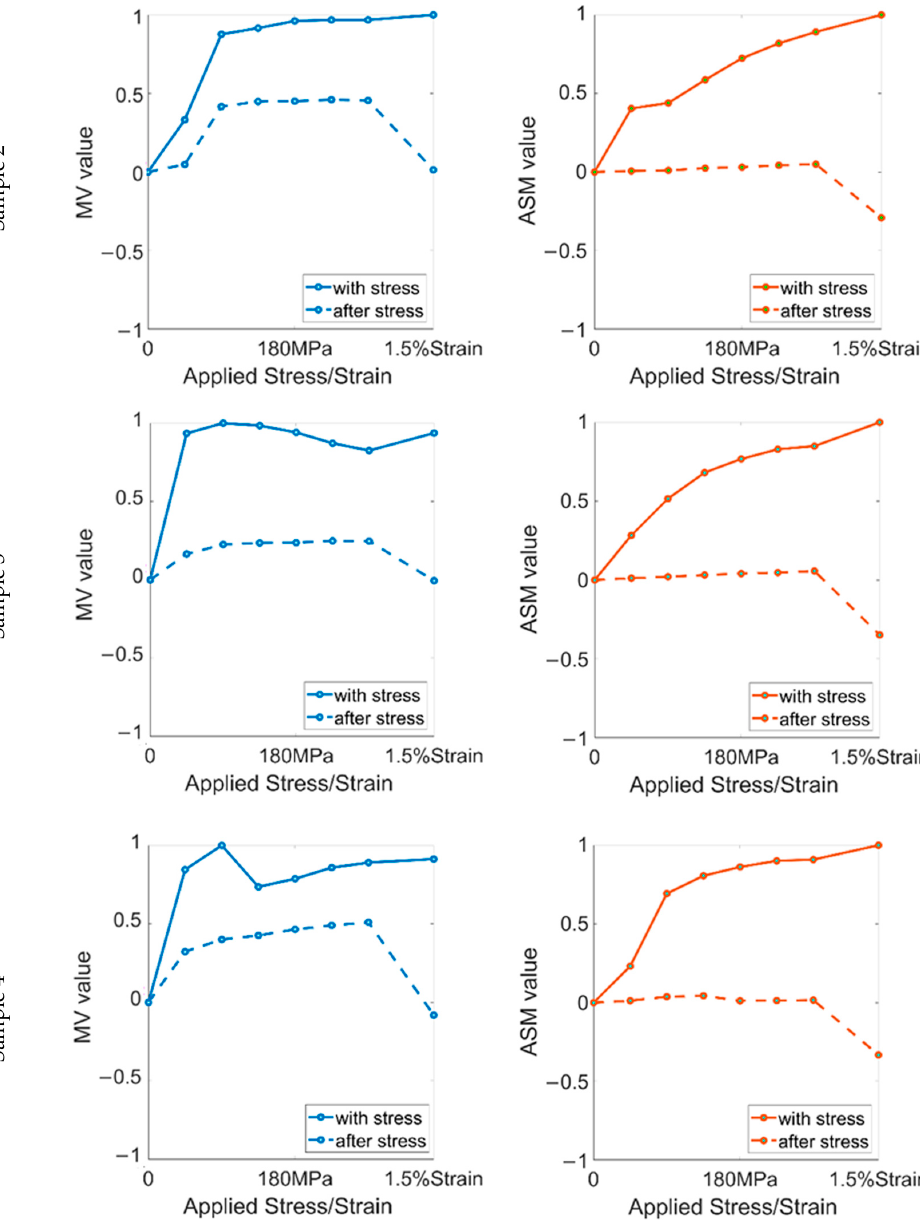
Figure 4. The relationship between RMF signal and applied stress/strain in the first stress round.